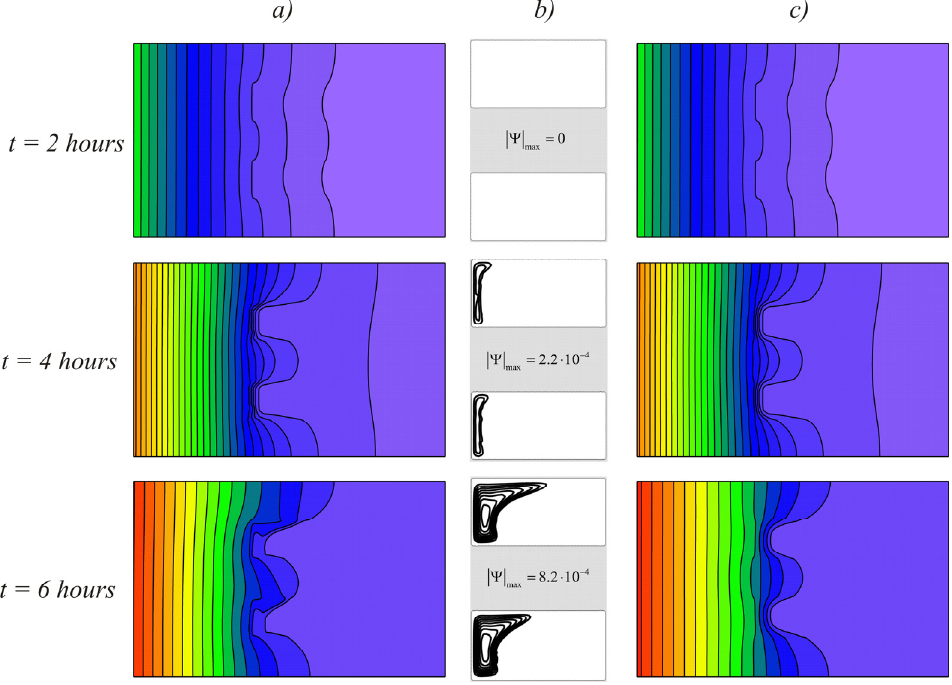
Figure 8. Temperature fields ( a ) and streamlines ( b ) for the case L = 0.02 m and ∆ T = 20° taking into account natural convection in the melt and temperature distributions obtained neglecting natural convection ( c ) at different times.